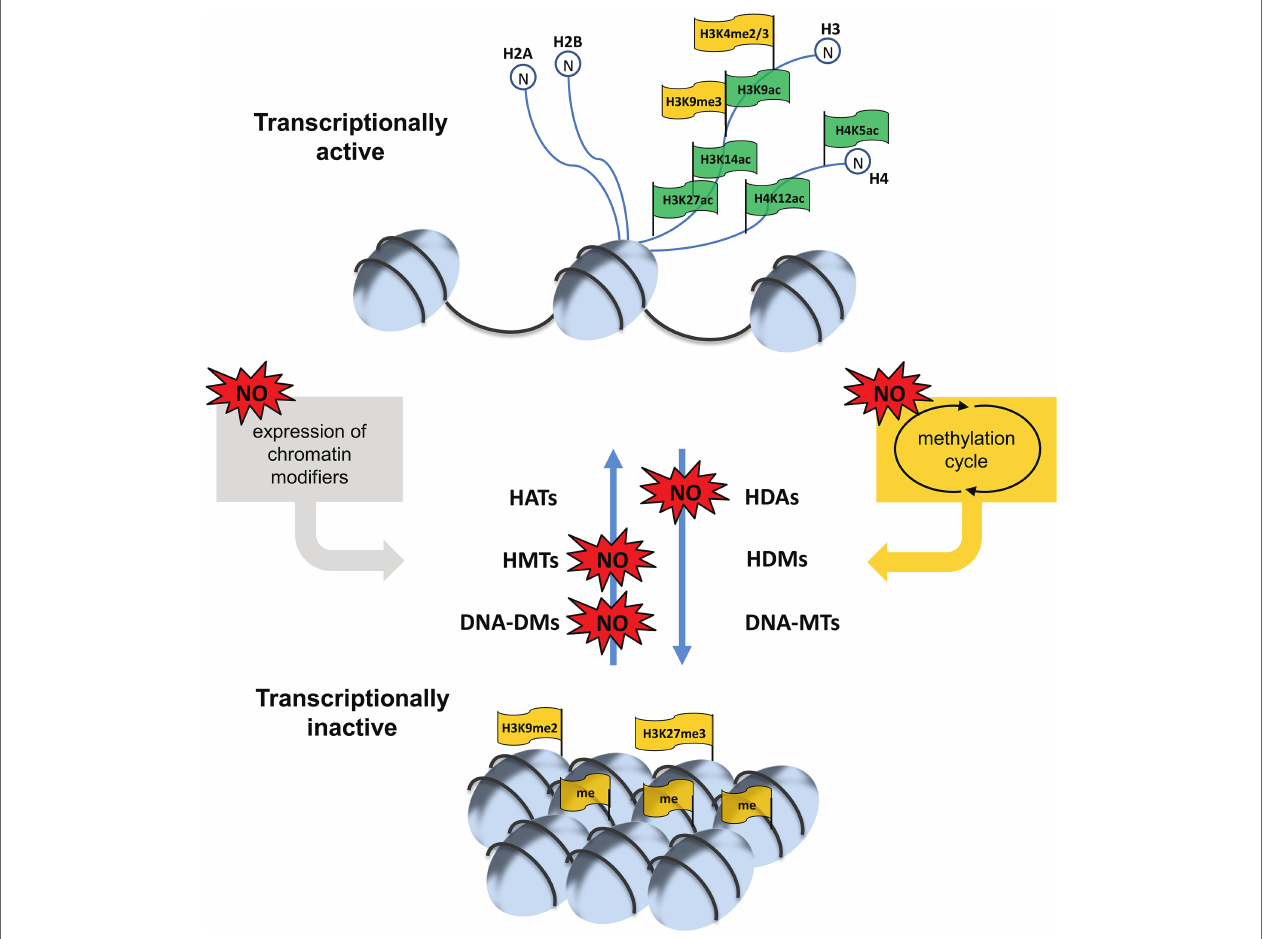
FIGURE 4 | NO-dependent regulation of chromatin modulation. Histone acetylation/methylation and DNA-methylation is controlled by different sets of acetylases/ deacetylases (HATs/HDAs) and methyl transferases/demethylases (HMT/HDMs and DNA-MTs/DNA-DMs). NO can regulate the expression of some of these chromatin modifiers as well as their activity. Moreover, NO can affect the supply of the methyl group donor SAM and the level of the methyltransferase inhibitor SAH by altering the activity of enzymes of the methylation cycle and/or connected pathways. For more details see this